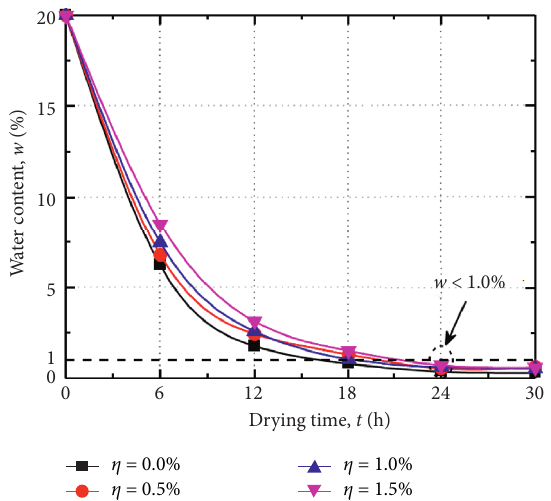
Figure 1: Variation of water content of the tested soil over drying